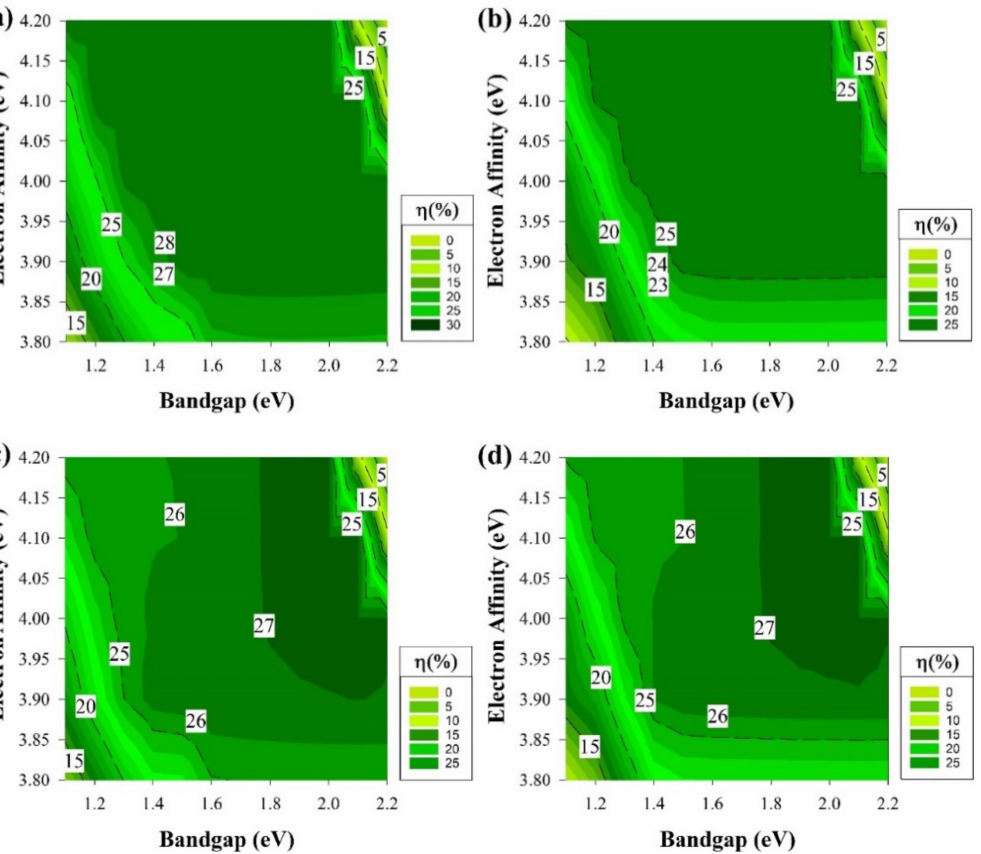
Figure 6. The efficiency of four proposed structures, including a-Si:H passivating layers as a function of Eg and χ for all doped layers without defects. ( a ) Contour graphs of the n-i-p structure with p-type wafer base. ( b ) Contour graphs of the n-i-p structure with n-type wafer base. ( c ) Contour graphs of the p-i-n structure with the p-type wafer. ( d ) Contour graphs of the p-i-n structure with n-type wafer